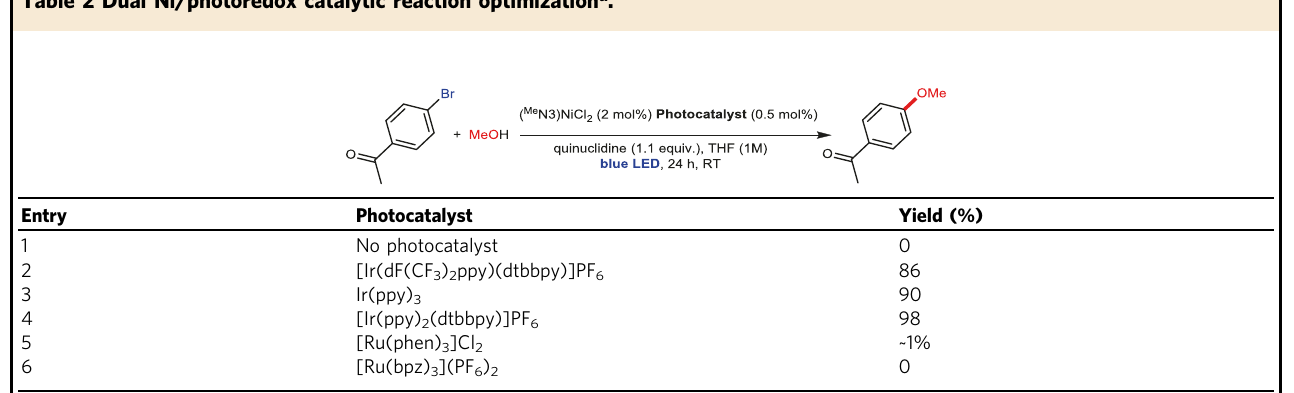
Table 2 Dual Ni/photoredox catalytic reaction optimization a .